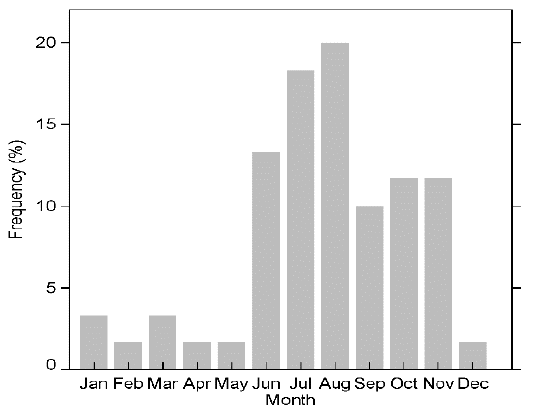
Figure 2. Percent of images with less than 30% cloud cover analyzed per month from September 1998 to August 2010.